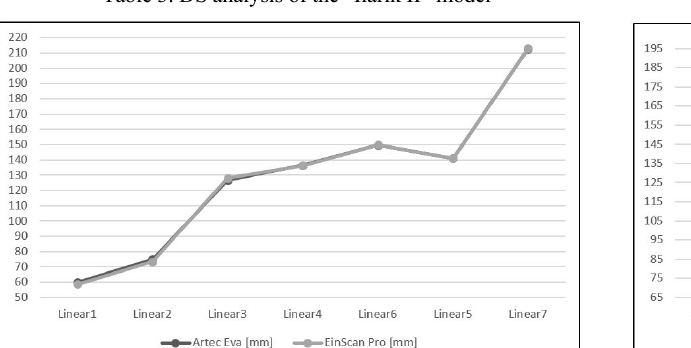
Table 3. DS analysis of the “Ilarik II” model